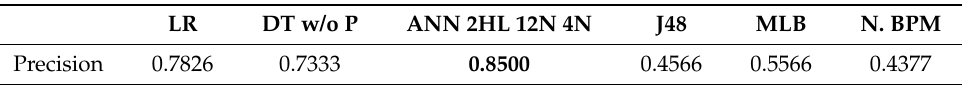
Table 4. Comparison of our results with respect to other works that used the same audio database.